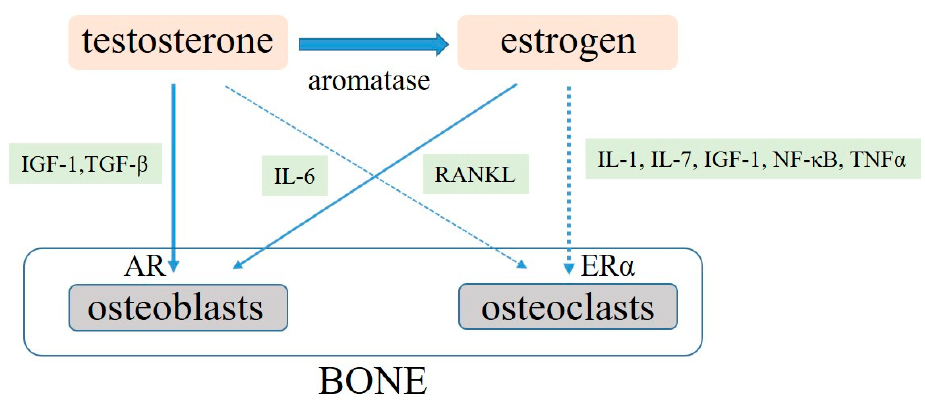
Figure 1. Molecular rules of testosterone and estrogen in bone metabolism. AR, androgen receptor; ER α , estrogen receptor α ; IGF-1, insulin growth factor-1; TGF β , transforming growth factor- β ; IL, interleukins; RANKL, receptor activator of NF- κ B ligand; NF- κ B, nuclear factor- κ B; TNF α , tumor necrotic factor- α .